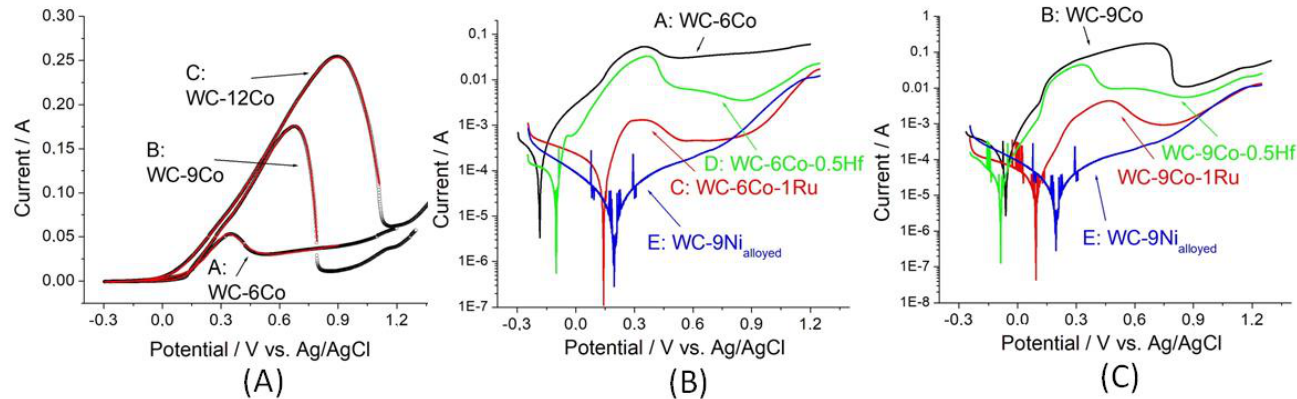
Figure 10. LSV curves of different CC grades in 0.5 M Na 2 SO 4 , scan rate: 1 mV s − 1 . ( A ) Effect of different Co binder fractions. The black plots are experimental curves, the red ones are fits (see text). ( B , C ) Impact of different binder compositions and fractions (indicated in the figure).